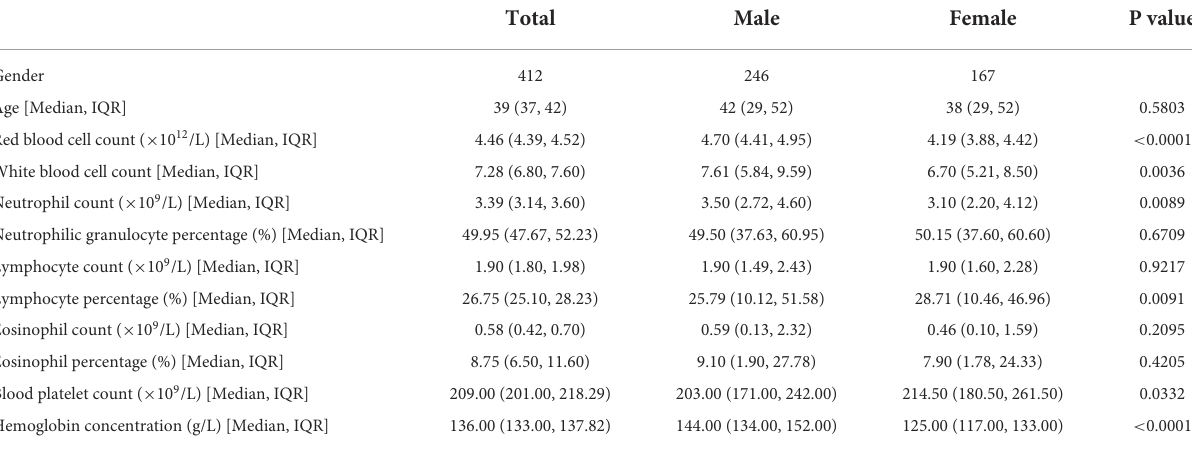
TABLE 3 Results of laboratory tests of the parasite-infected patients. Total Male